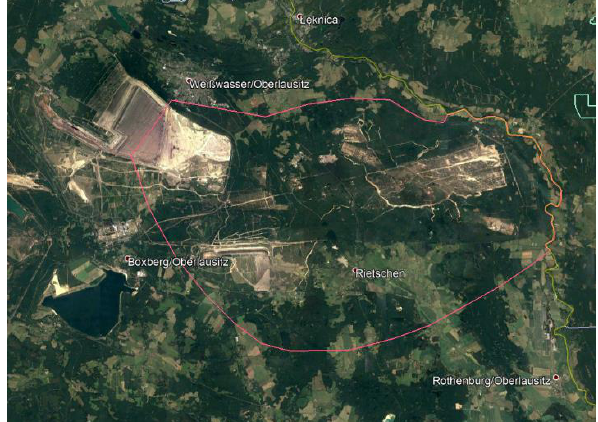
Figure 1: Project area of the Firebird